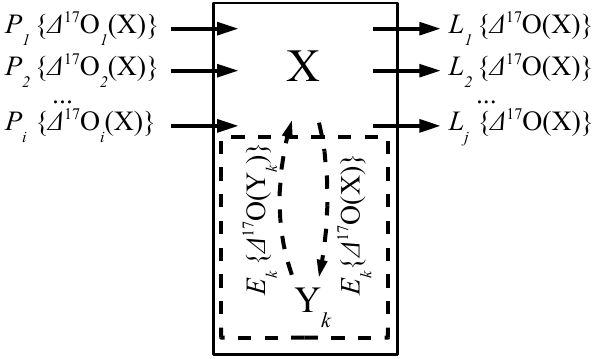
Fig. 1. Schematic representing the isotopic mass-balance equation including one isotopic exchange reaction. Arrows represent pro- duction (or destruction) fluxes. The flux is given by the P , L and E terms, while the corresponding transferred 1 17 O value is given in brackets. The solid box represent the chemical budget of the species X, while the dashed box takes into account the full isotopic budget of the species X. The scheme illustrates that isotopic exchange re- actions have no impact on the chemical budget of a given species